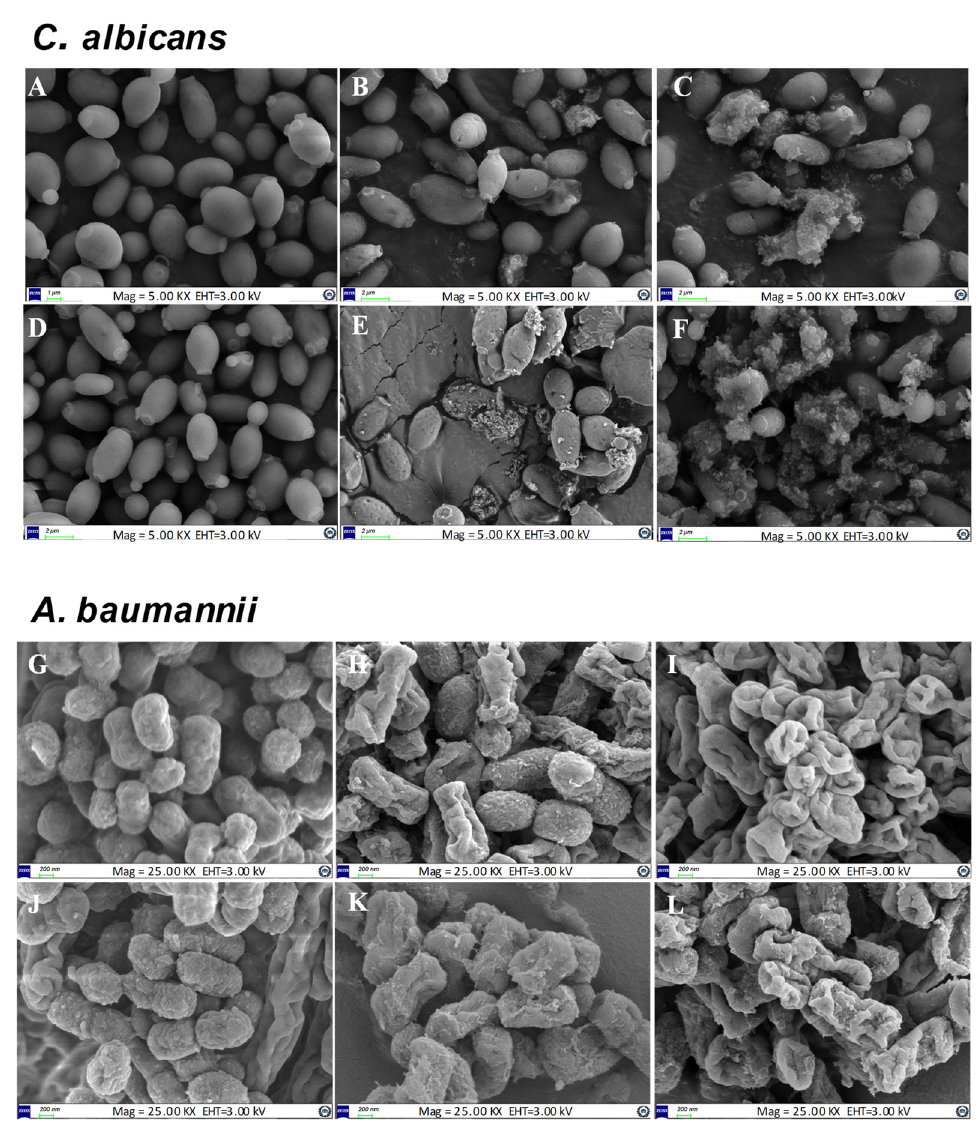
Figure 4. Comparison of morphological and structural alterations of C. albicans and A. baumannii upon Octominin-CNPs, Octominin, and CNPs treatments. C. albicans was treated with ( A ) 1 × phosphate buffered saline (PBS), ( B ) Octominin MIC (50 µg/mL), ( C ) Octominin MFC (200 µg/mL), ( D ) CNPs (200 µg/mL), ( E ) Octominin-CNPs (50 µg/mL), and ( F ) Octominin-CNPs (200 µg/mL). A. baumannii was treated with ( G ) PBS, ( H ) Octominin MIC (5 µg/mL), ( I ) Octominin MBC (10 µg/mL), ( J ) CNPs (10 µg/mL), ( K ) Octominin-CNPs (5 µg/mL), and ( L ) Octominin-CNPs (10 µg/mL). After 12 h of treatment, fungi/bacteria were fixed with glutaraldehyde (5%) and coated with platinum. Fungi/bacteria were observed under field emission scanning microscopy . The scale bar for C. albicans is 2 µm and for A. baumannii is 200 nm.